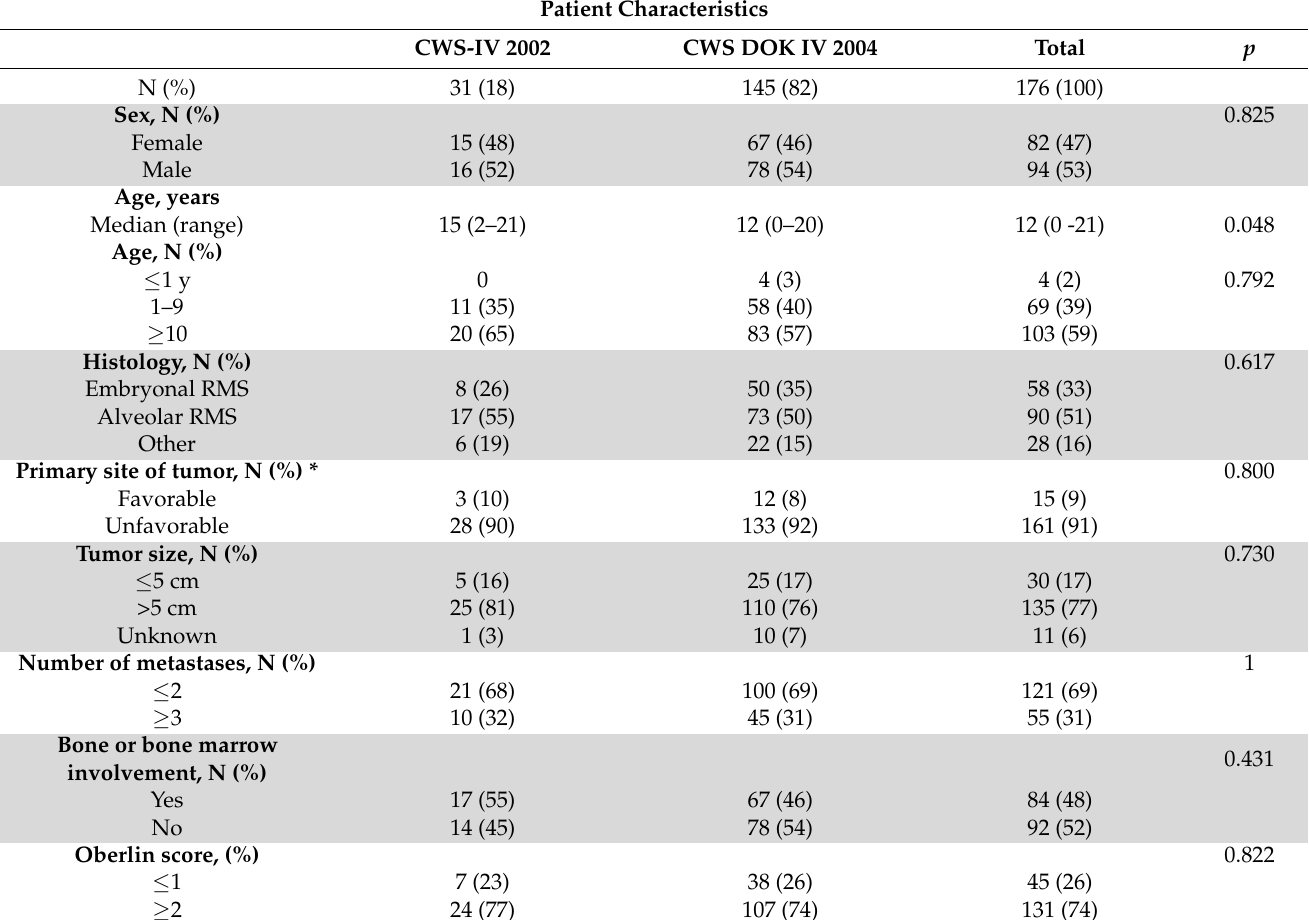
Table 1. Patient characteristics by initial treatment